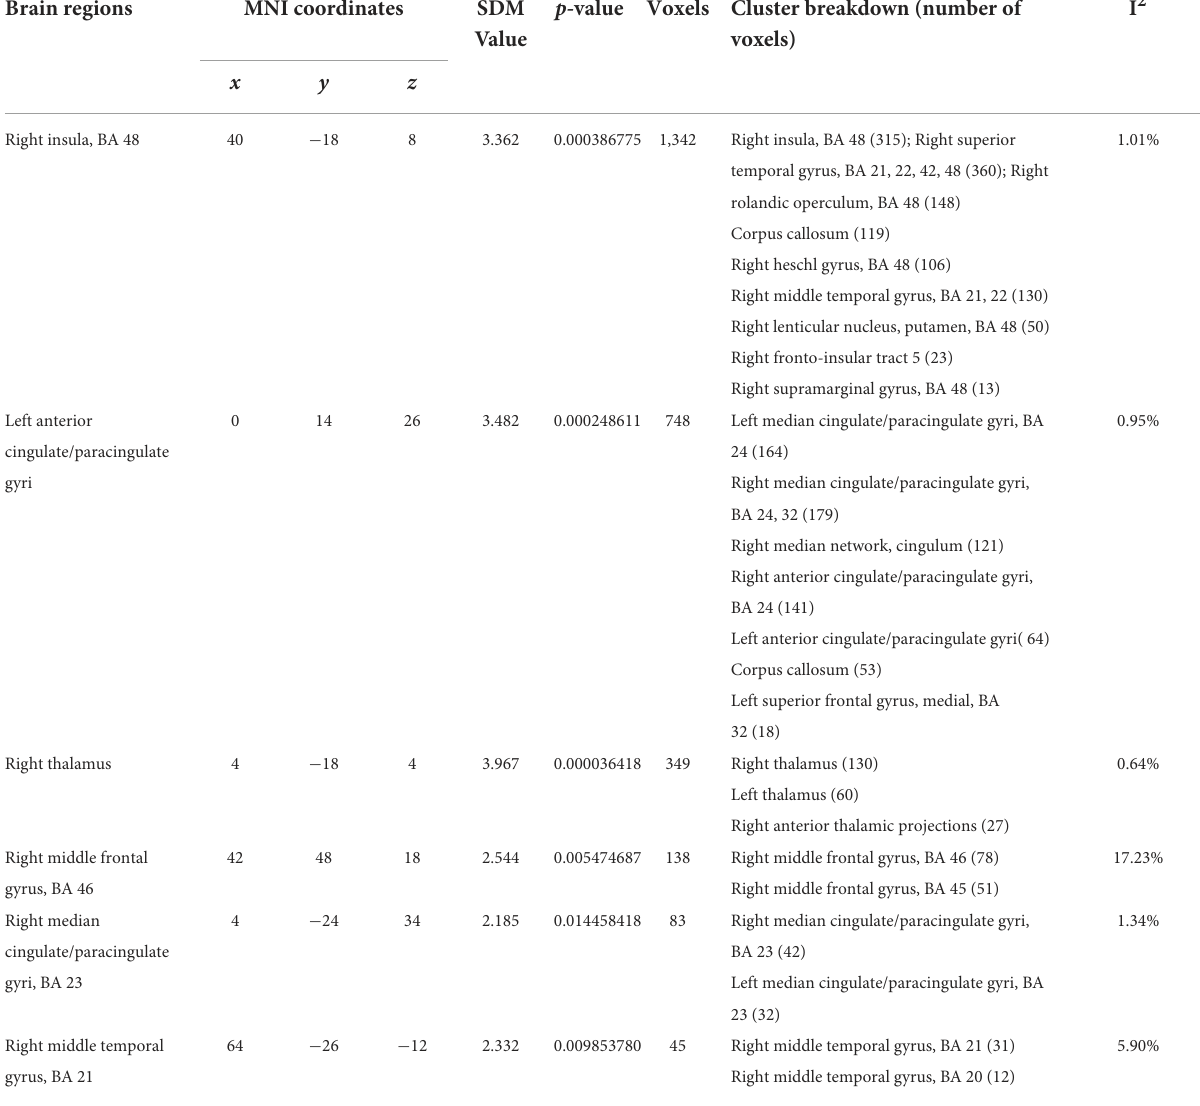
TABLE 3 Regional differences in brain gray matter volume activity PRE and POST acupuncture treatment in the coordinate-based meta-analysis. Brain